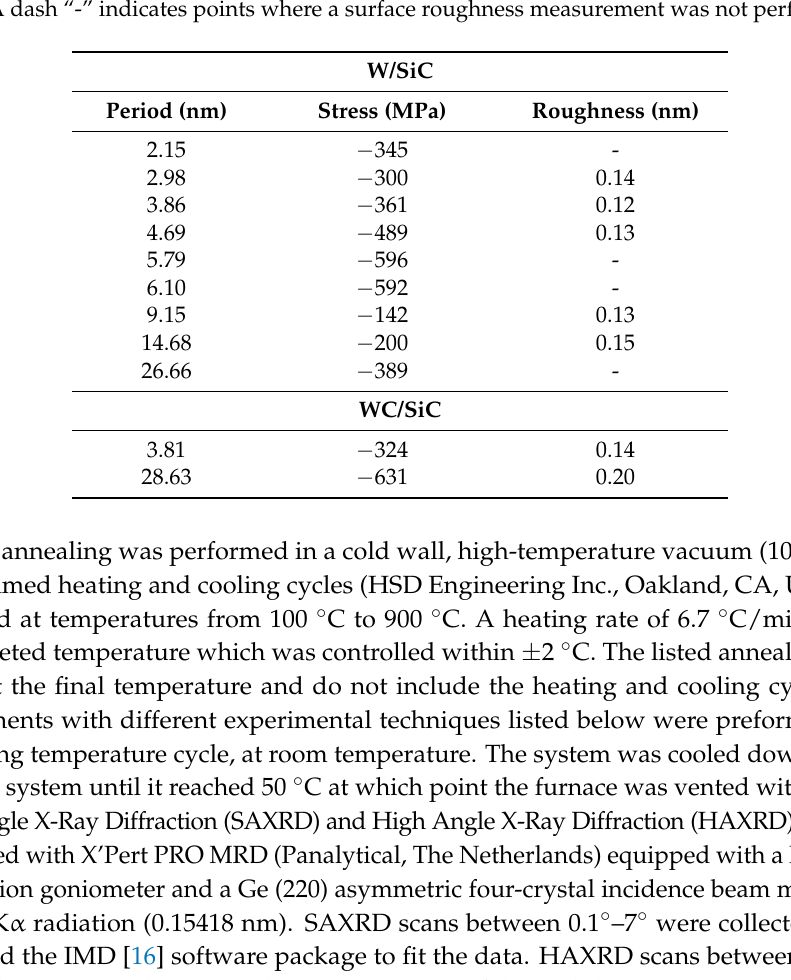
Table 1. Stress and surface roughness in as-deposited W/SiC and WC/SiC multilayers of different periods. A dash “-” indicates points where a surface roughness measurement was not